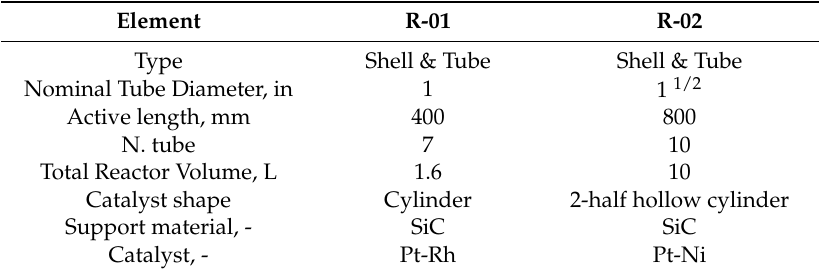
Table 4. Main characteristics of closed-architecture membrane reactors.